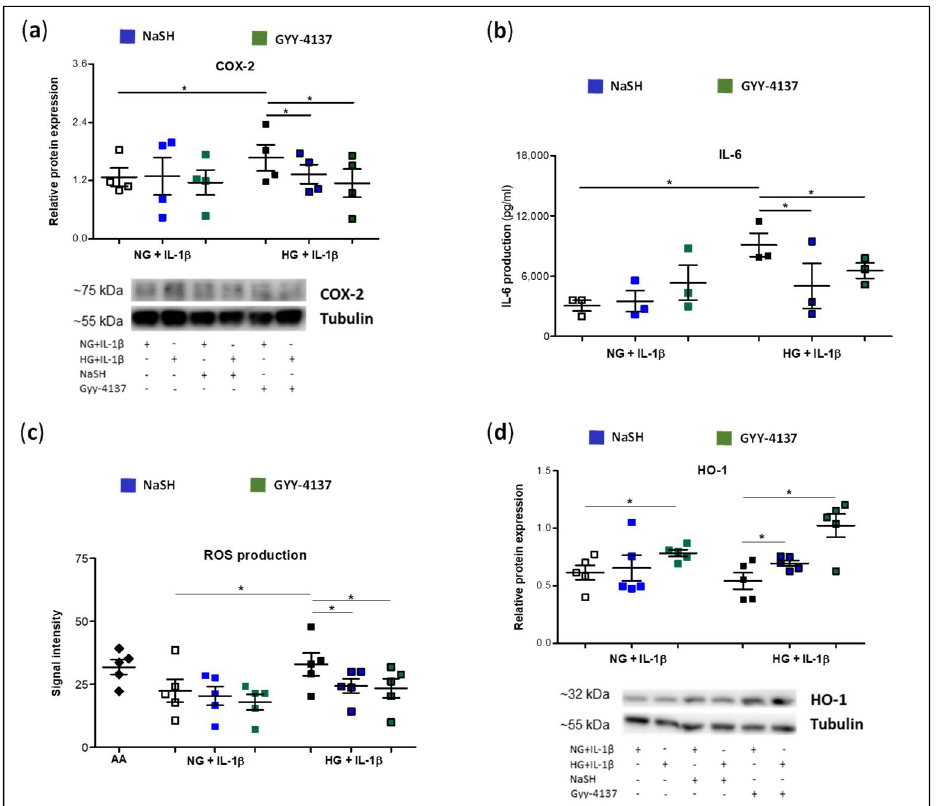
Figure 5. Effect of exogenous administration of H 2 S on pro-inflammatory and pro-oxidant responses to IL-1β and HO-1 expression recovery in chondrocytes exposed to a HG environment. OA human chondrocytes were incubated in growth media with normal (NG) or high (HG) levels of glucose in the presence or absence of IL-1β and co-treated with a fast or slow-releasing H 2 S donor, NaSH 500 µM and GYY-4137 500 µM, respectively. Then, ( a ) protein levels of COX-2 were measured by western blot. Below panel shows representative images of COX-2 expression from one experiment. Expression levels of β-tubulin were employed as the loading control. ( b ) IL-6 released in the cell culture supernatant was measured by ELISA. ( c ) ROS production was monitored by flow cytometry using the fluorogenic dye 2′, dichlorofluorescein (DCF). Antimycin A (AA) was employed as a positive control of ROS production. ( d ) Protein HO-1 expression was also evaluated. Below panel shows representative images of HO-1 expression from one experiment. Values are mean ± SEM. * p ≤ 0.05 analysed by the Wilcoxon test. COX-2, cyclooxygenase 2; HO-1, hemeoxygenase-1; IL-6, interleukin 6.